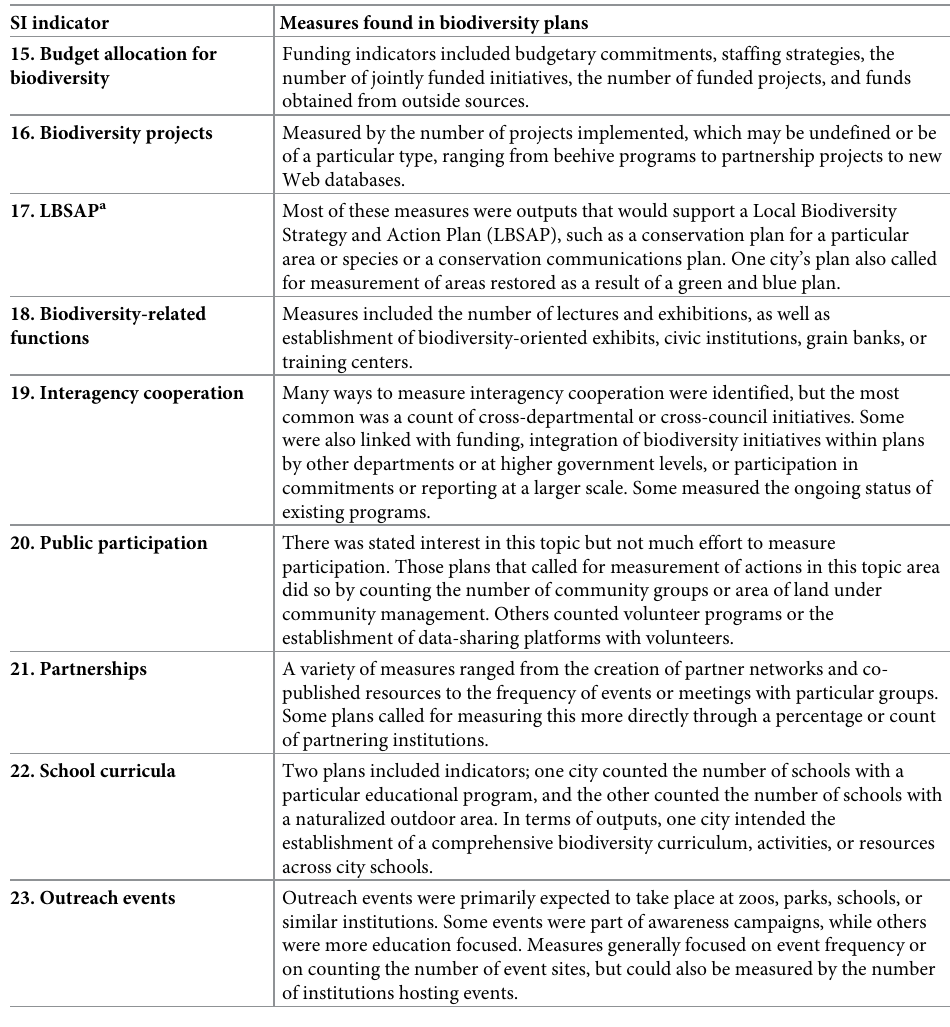
Table 4. Measures for governance and